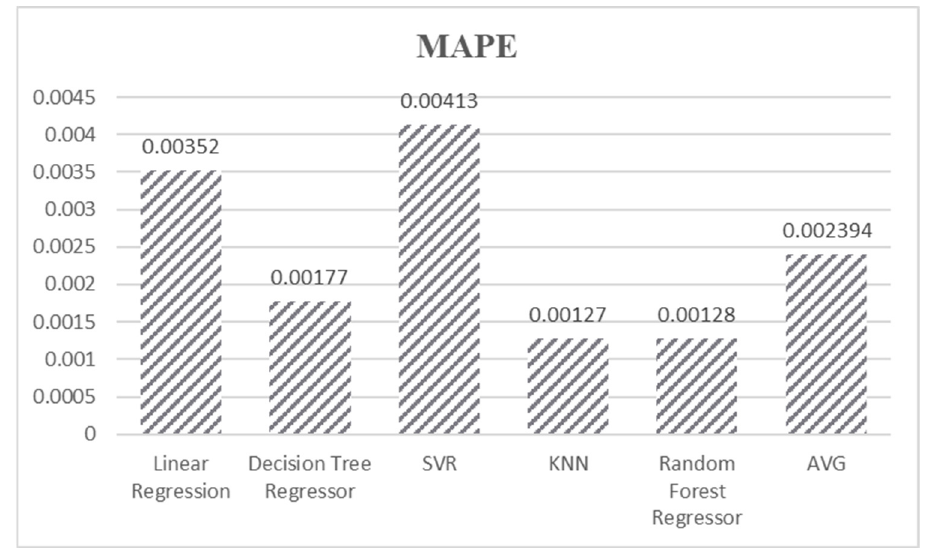
Figure 5. Mean Absolute Percentage Error of five prediction models.